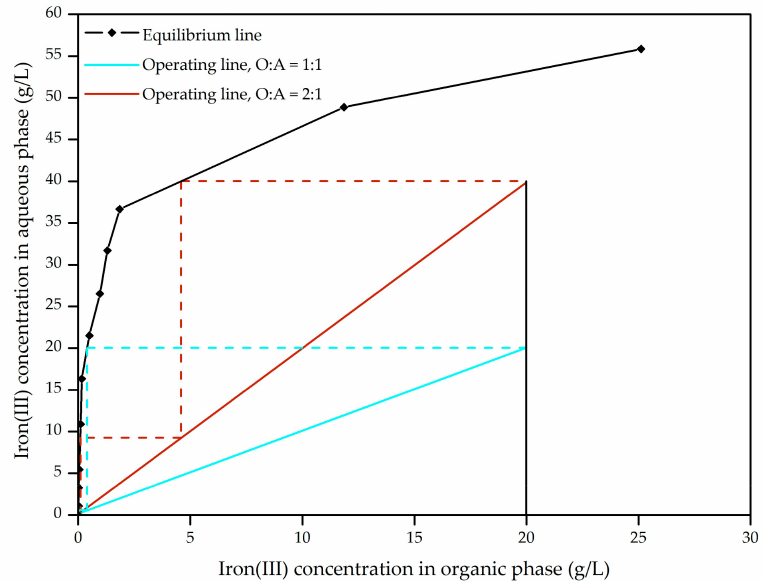
Figure 11. McCabe–Thiele plot for iron(III) stripping at different concentrations in the organic phase at O:A = 1:1, C(HCl)aq. = 0.2 M.